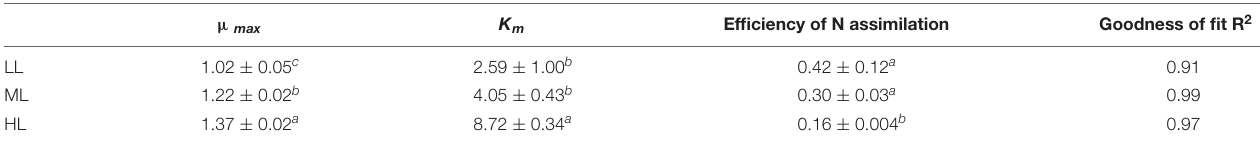
TABLE 1 | The µ max , K m , and efficiency of N assimilation in Gephyrocapsa oceanica cells grown under different levels of photosynthetically active radiation (PAR) (LL: 50 µ mol photons m − 2 s − 1 , ML: 115 µ mol photons m − 2 s − 1 , and HL: 260 µ mol photons m − 2 s − 1 ), which were derived from the relationship of growth vs. nitrate concentrations ( Figure 1 ).